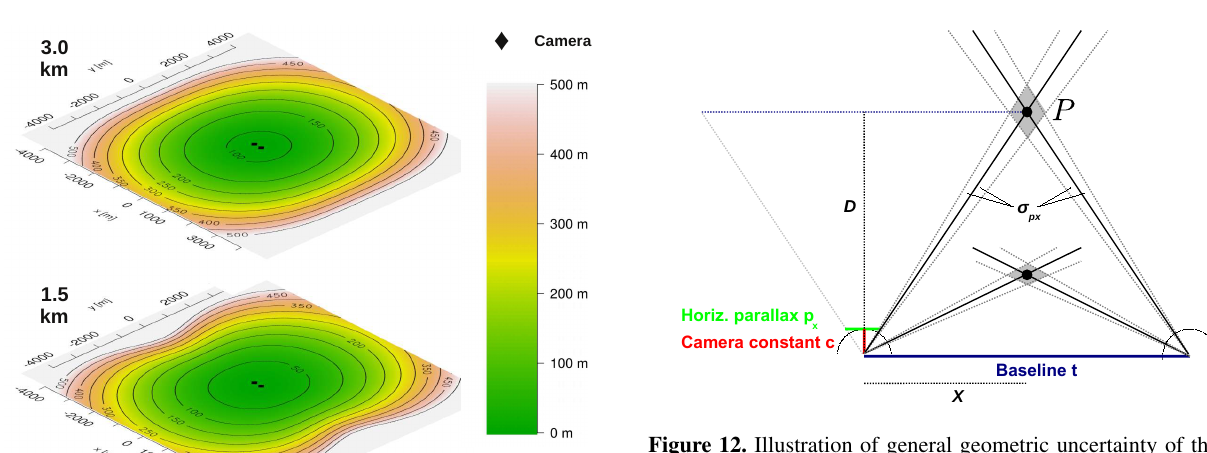
Figure 12. Illustration of general geometric uncertainty of the re- construction within an epipolar plane: an uncertainty in the projec- tion rays σ p introduces an uncertainty in the estimated location of x P indicated by the gray region: a smaller/higher depth value D (or higher/smaller parallax p x ) reduces/increases the depth uncertainty σ D , but reduces/increases the horizontal uncertainty σ X for the sky imager and 67 ◦ for the wide-angle camera leads to (cid:127) fish = 6 . 28 and (cid:127) wide = 1 .